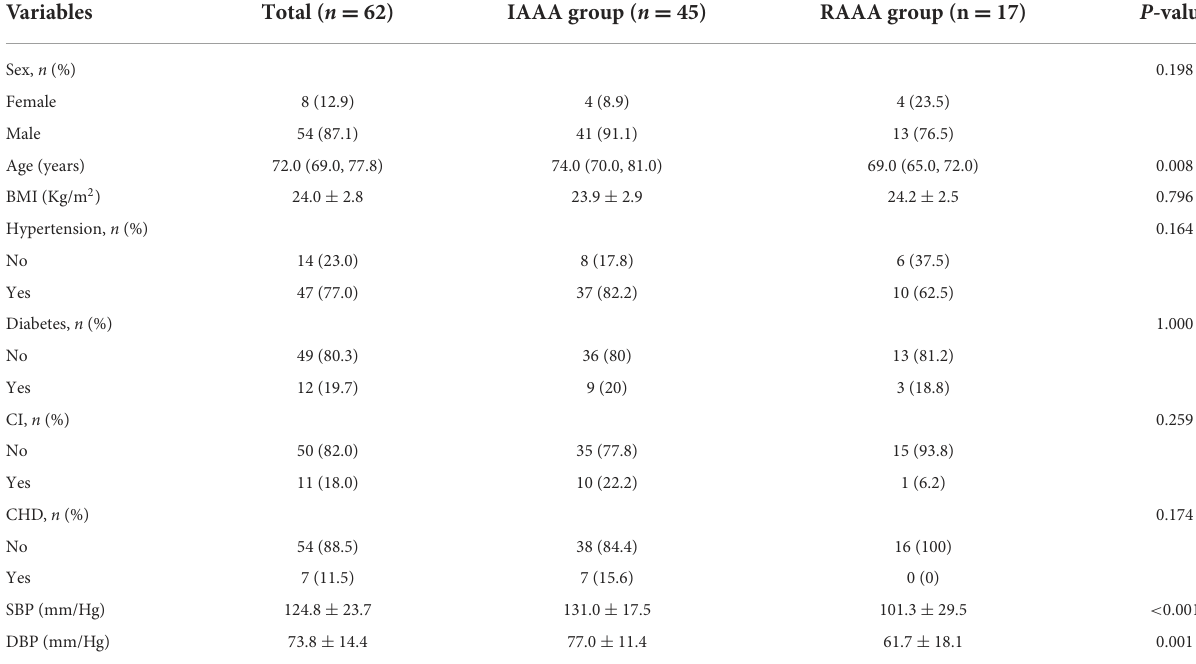
TABLE 1 Baseline information of intact and ruptured abdominal aortic aneurysms.